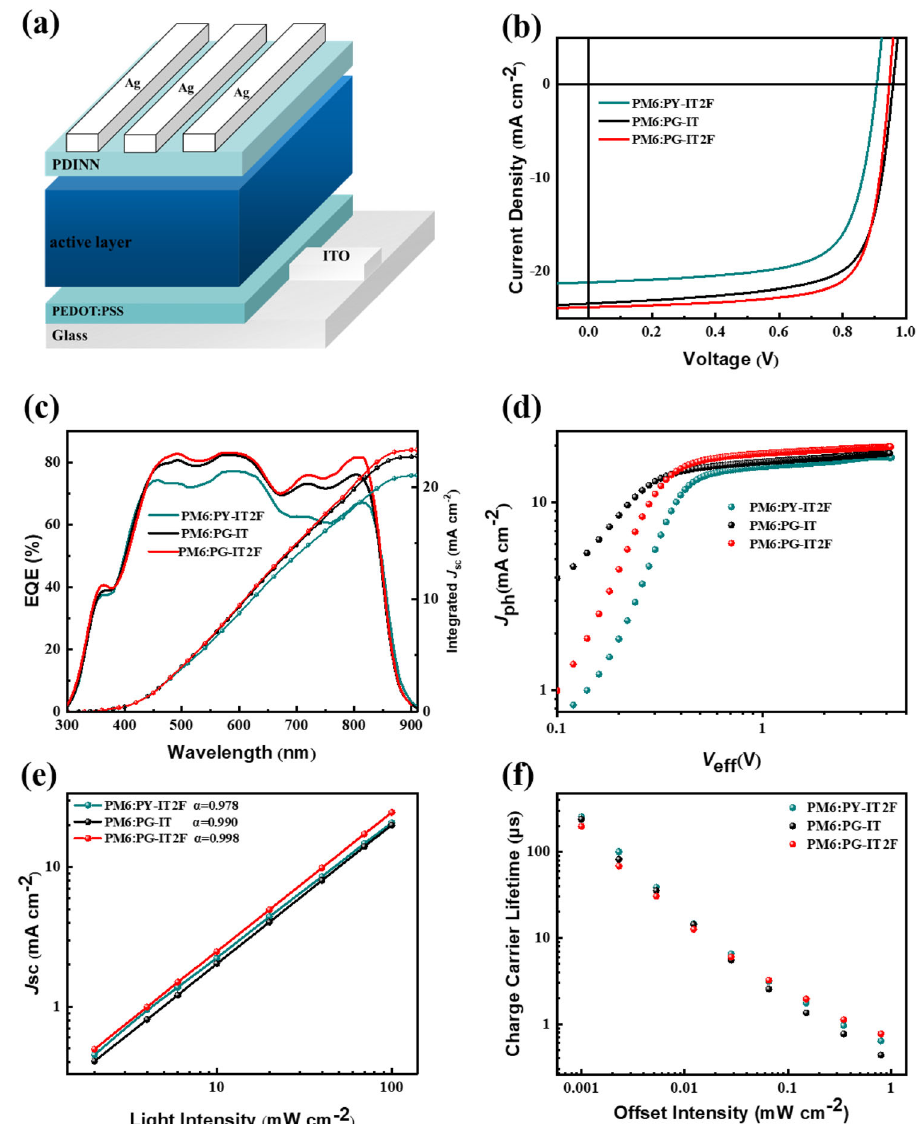
Fig. 2 | Device structure and photovoltaic performance ofthe all-PSC. a Device structure of the all-PSCs. b J-V curves of the optimized all-PSCs based on PM6:PSMAs under the illumination of AM1.5G, 100mWcm − 2 . c EQE curves of the corresponding all-PSCs. d J ph versus V eff of the all-PSCs. e Light intensity